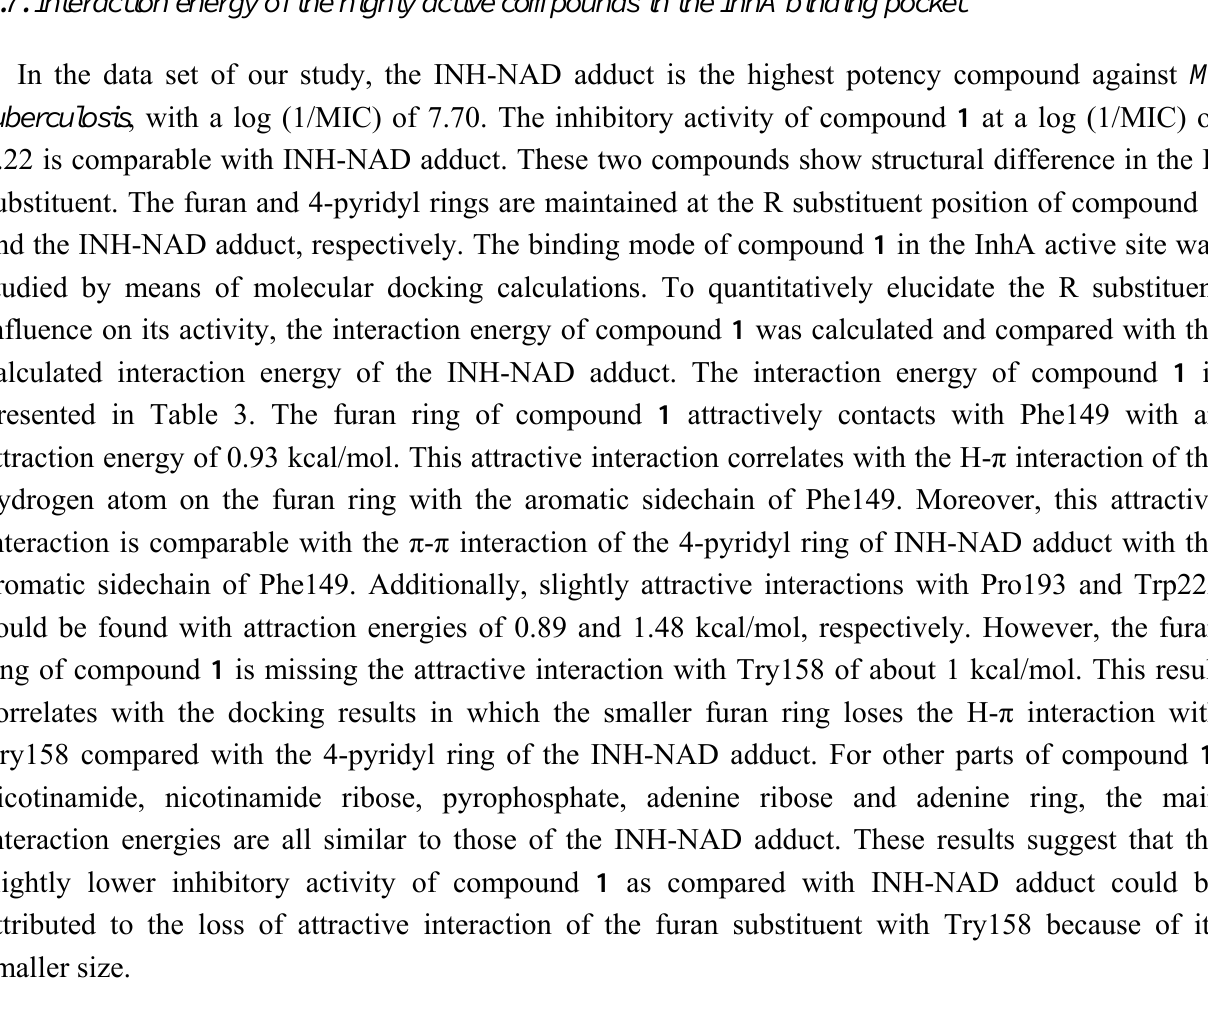
Table 3. Interaction energy between each part of the adducts of INH, compounds 1, 33, 35 and each amino acid surrounding within 6 Å from each part of adducts in InhA binding